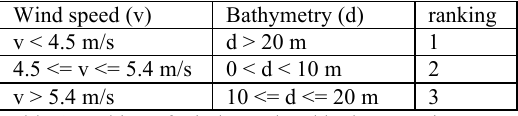
Table 4: ranking of wind speed and bathymetry